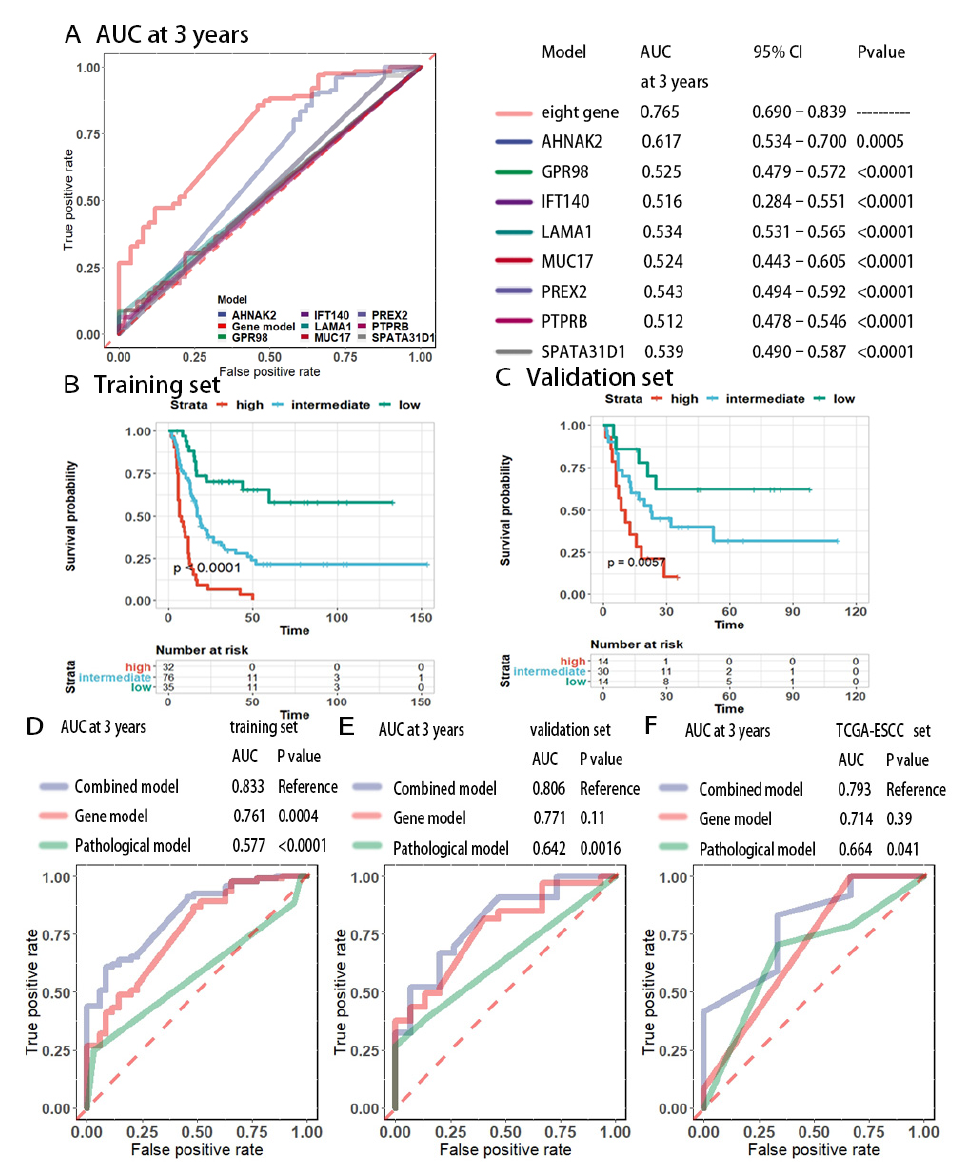
Figure 3. Performance of the eight-gene model in the training and validation sets. ( A ) AUC of the time–dependent ROC curve for the eight–gene predictor and the individual genes across the entire cohort. ( B , C ) Patients stratified by risk scores had distinct DFS in the training set ( B ) and validation set ( C ). ( D – F ) Time–dependent ROC curves compared the prognostic accuracies of the combined model integrating the eight–gene signature and pathological staging with pathological staging in